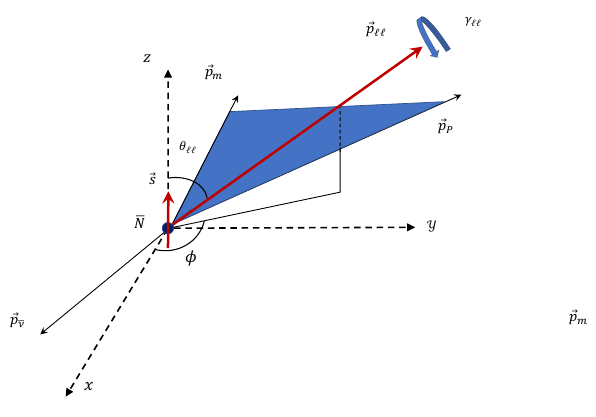
Figure 3 . Kinematic variables for ¯ N → ‘ − ‘ + ¯ ν